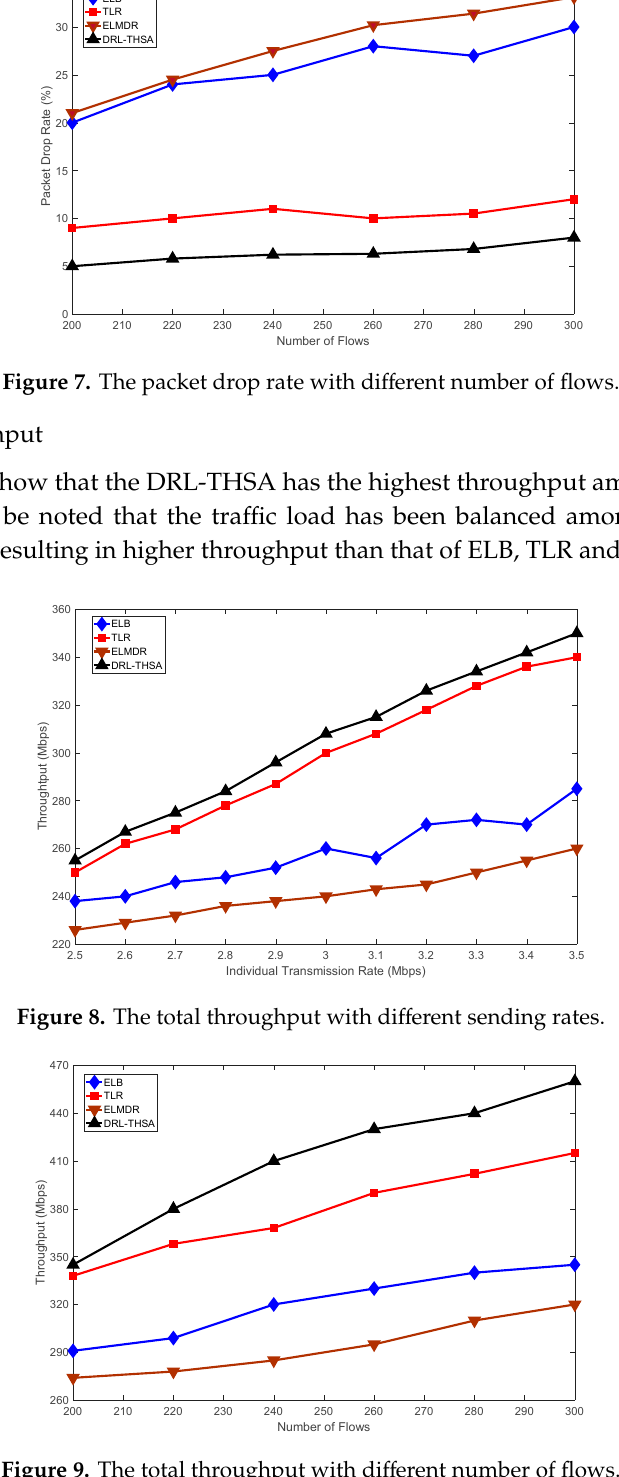
Figure 9. The total throughput with different number of flows.